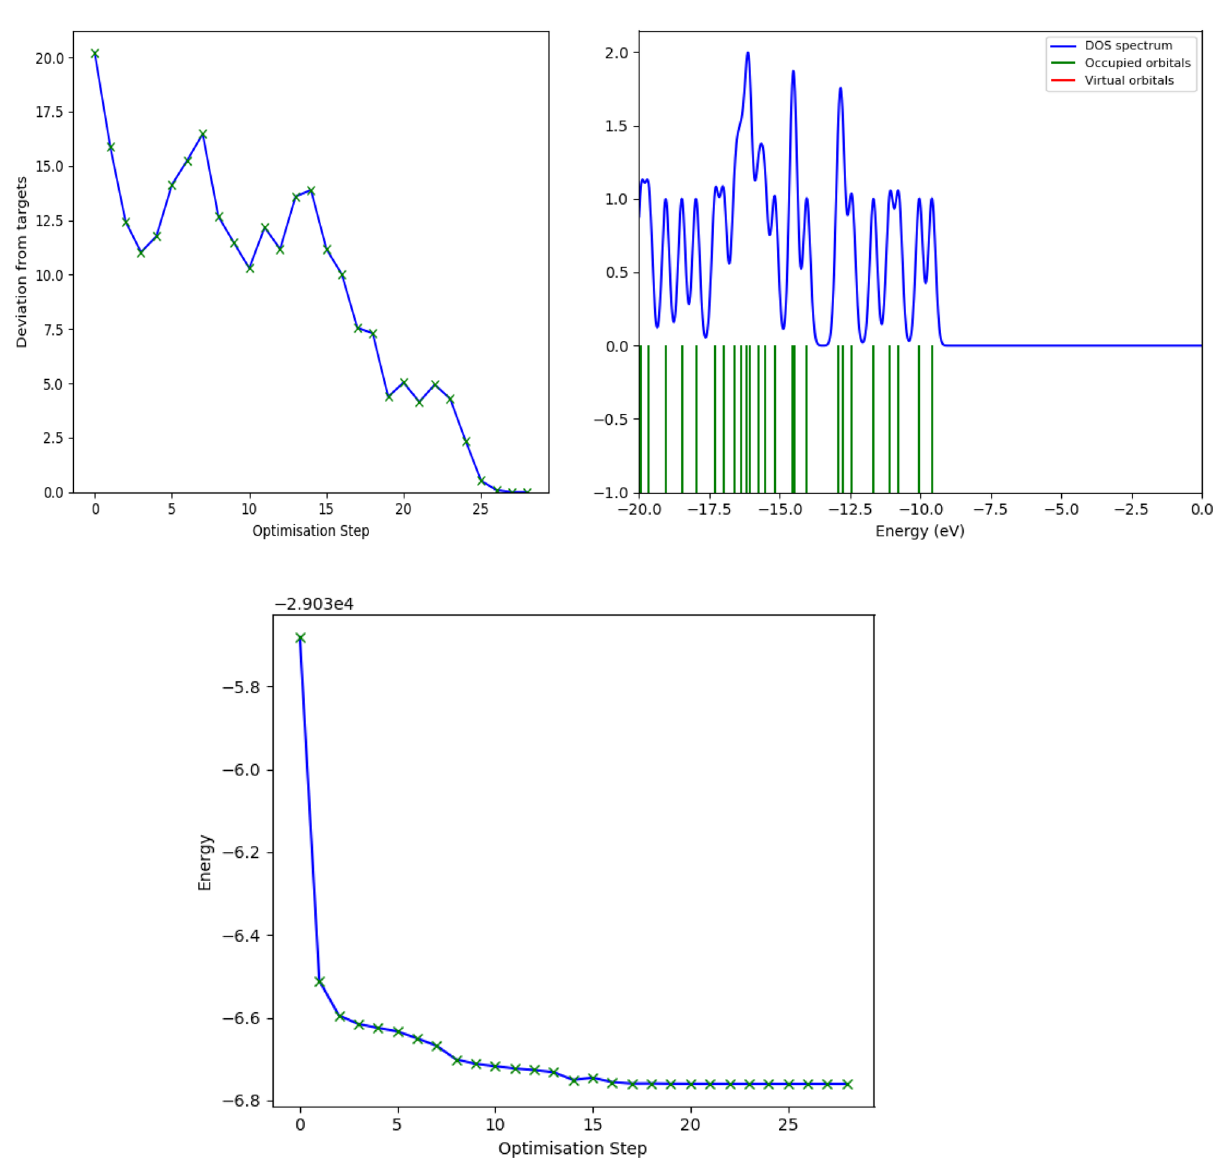
Figure 18. Acetamiorid DOS and Energy